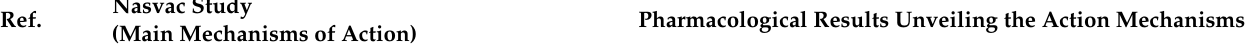
Table 1. Summary of HeberNasvac immunomodulatory and antiviral effects at the cellular